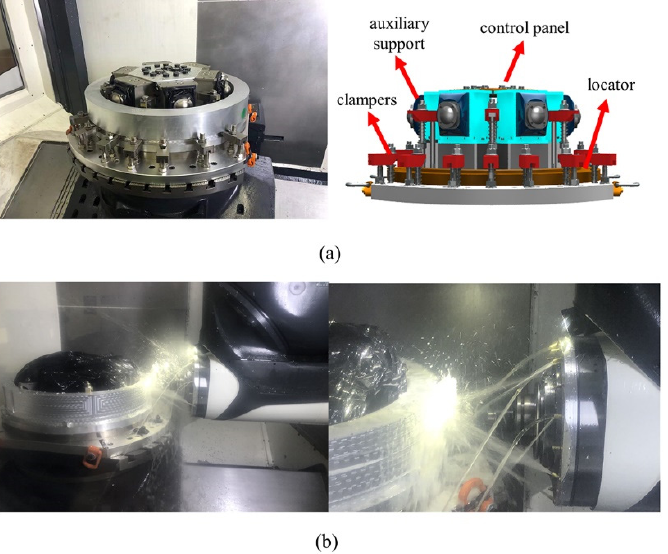
Figure 11. The physical machining environment and machining process. ( a ) The physical machining environment; ( b ) Machining process.